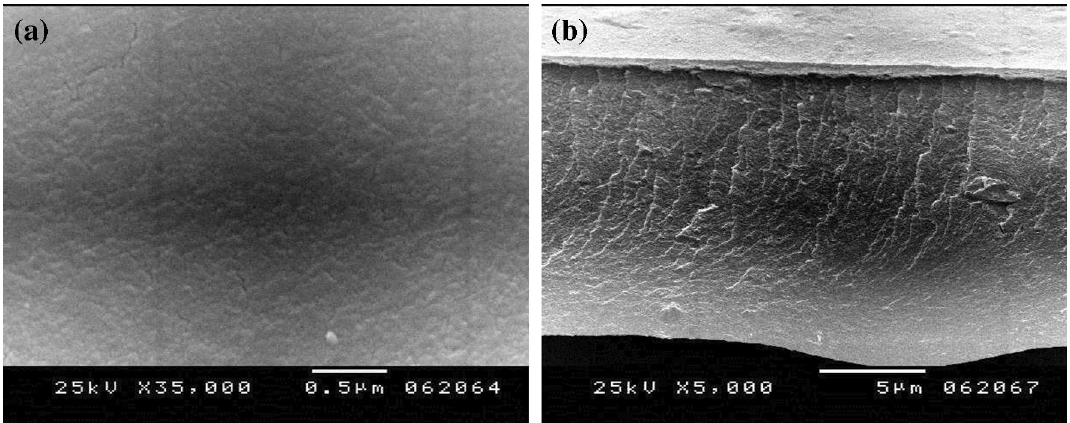
Figure 9. SEM analysis of CA-PEG blend membrane ( a ) Surface morphology, and ( b ) Cross-sectional